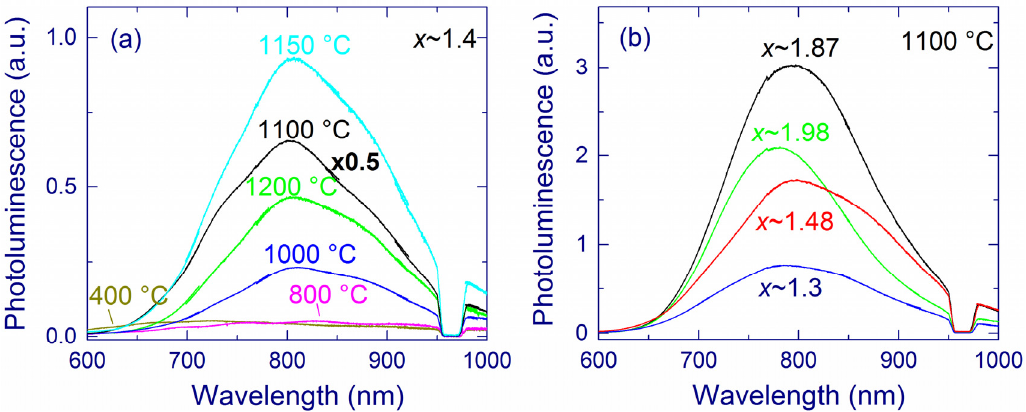
Figure 6. Photoluminescence (PL) spectra of ( a ) a SiO 1.4 film annealed at